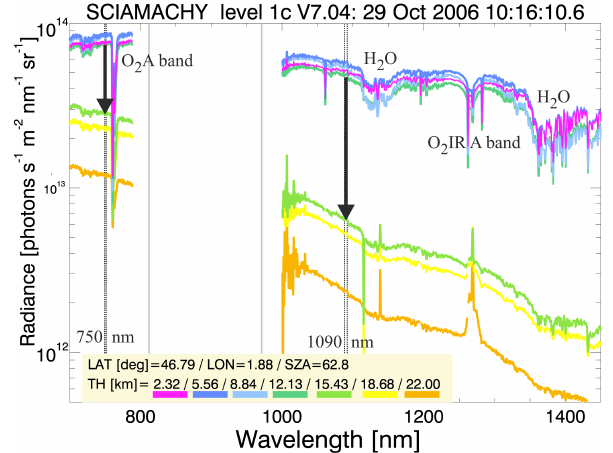
Figure 4. Time series of one limb tangent height (in km) covering the SCIAMACHY mission lifetime; e.g. TH(3) is the tangent height with index number 3. Daily means were plotted, taken from the first state of 10 orbits of 1 day per month (usually the first day). The dashed blue lines depict the corresponding 2 σ standard deviation. The red line shows the tangent height step width, which is here the difference TH(4)–TH(3) between two adjacent tangent